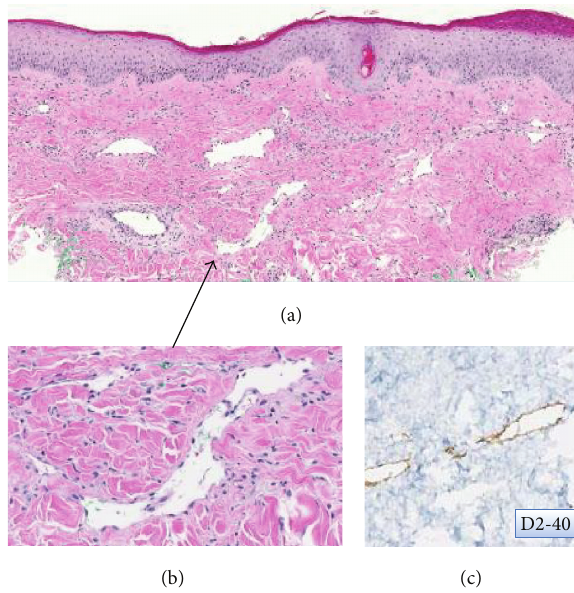
Figure 3: Cutaneous breast scar lymphedema. (a) shows a dermal scar with numerous dilated lymphatic vessels in a background of fibrosis. (b) highlights a markedly dilated lymphatic vessel (arrow). (c) confirms the presence of lymphangiectases by D2-40 expression (lymphatic